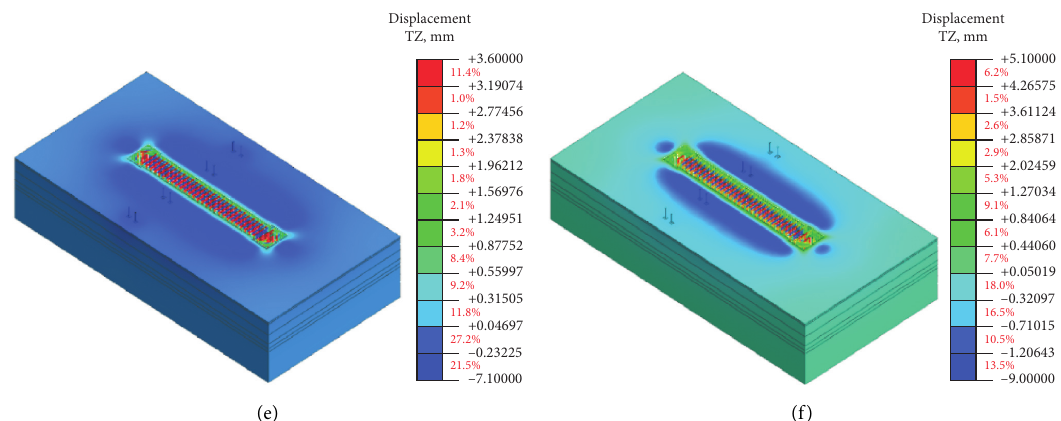
Figure 11: Settlement deformation nephogram. (a) Working condition 1. (b) Working condition 2. (c) Working condition 3. (d) Working condition 4. (e) Working condition 5. (f) Working condition